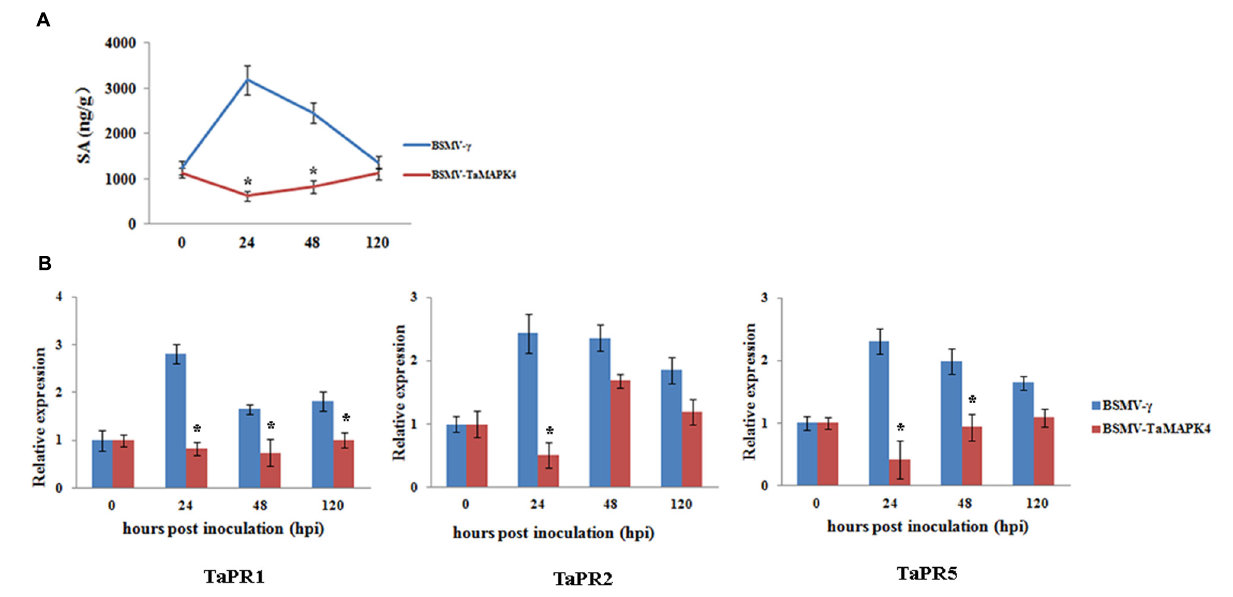
FIGURE 5 | Salicylic acid accumulation and transcript levels of pathogenesis-related ( PR ) genes in TaMAPK4 knockdown leaves. (A) SA accumulation in TaMAPK4 knockdown leaves inoculated with Pst race CYR23. SA, salicylic acid; ng/g, SA accumulation (ng) per fresh leaves weight (g); (B) Transcript levels of TaPR1 , TaPR2 , and TaPR5 genes in TaMAPK4 knockdown leaves challenged with Pst race CYR23. TaPR1 , pathogenesis-related protein 1; TaPR2 , β -1,3-glucanase; TaPR5 , thaumatin-like protein. BSMV- γ leaves infected with Pst race CYR23 were used as control. Means and standard deviations were calculated from three independent replicates. Significant differences were determined using Student’s t -test: ∗ P <